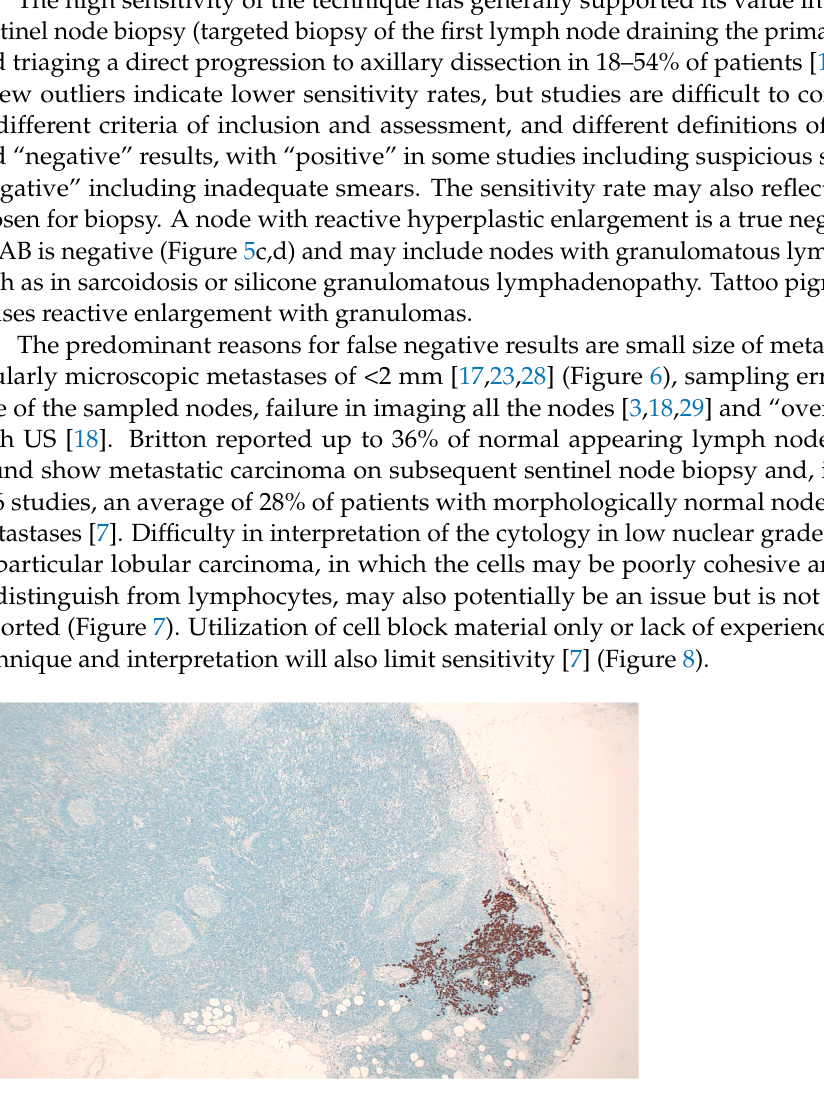
Figure 6. Microscopic metastasis identified following a negative FNAB (see image 5e). Cam 5.2 cytokeratin immunostaining × 20.